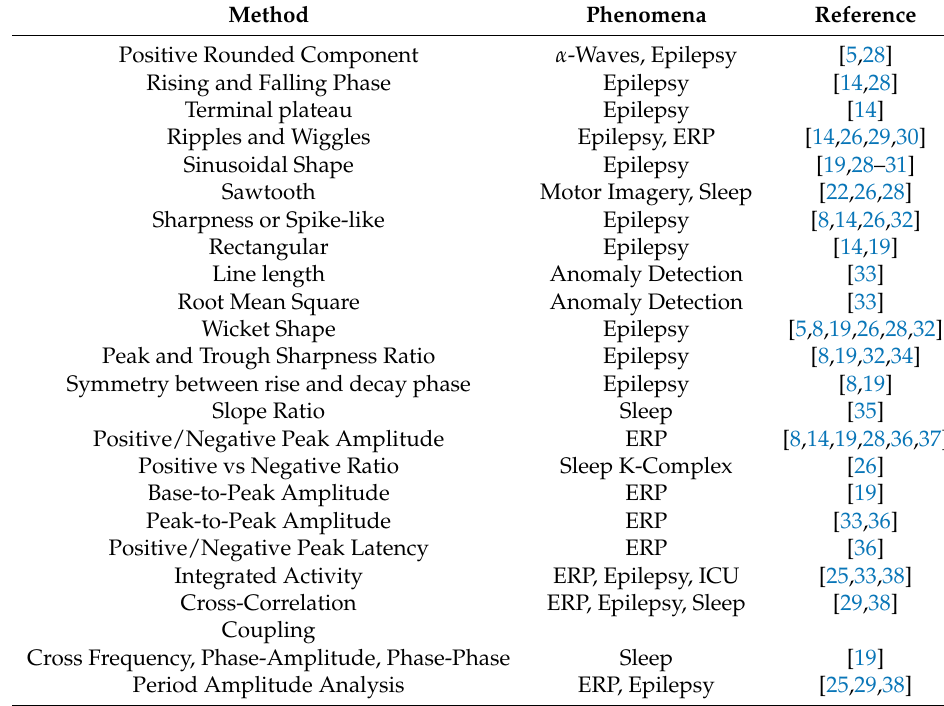
Table 1. EEG waveforms descriptions found in the surveyed